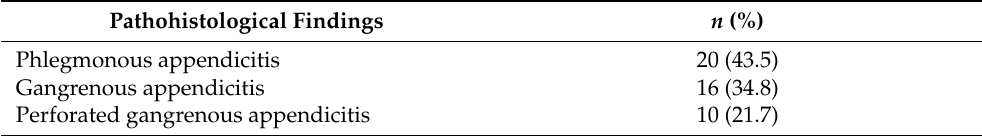
Table 2. Pathohistological analysis of removed specimens in the acute appendicitis group.